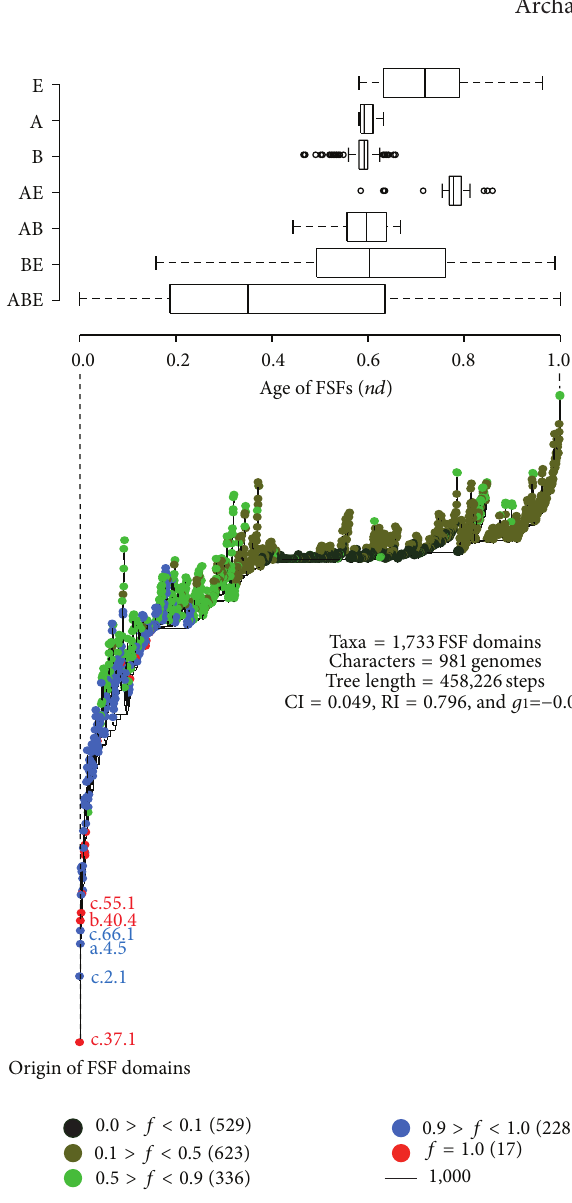
Figure 10: Phylogenomic tree of domains (ToD) describing the evolution of 1,733 FSF domain structures. Taxa (FSFs) were colored according to their distribution ( 𝑓 ) in the 981 genomes that were sur- veyed and used as characters to reconstruct the phylogenomic tree (data taken from [122, 123]). The most basal FSFs are labeled with SCOP alphanumeric identifiers (e.g., c.37.1 is the P-loop containing nucleosidetriphosphatehydrolaseFSF).Boxplotsdisplaytheage( nd value) distribution of FSFs for the seven possible taxonomic